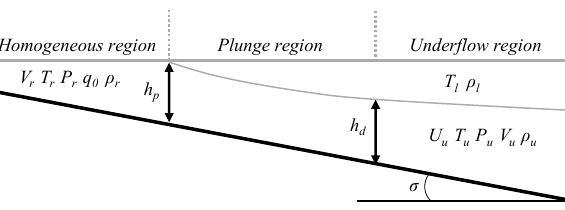
Figure A1. Illustration of river intrusion model.